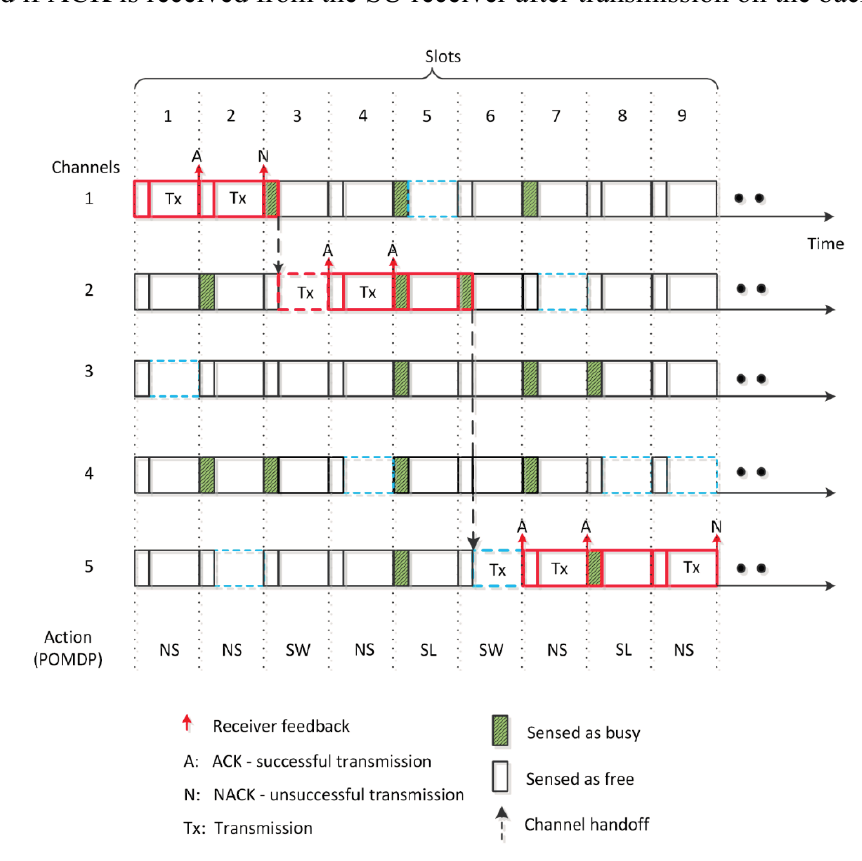
Figure 3. Operation of the proposed